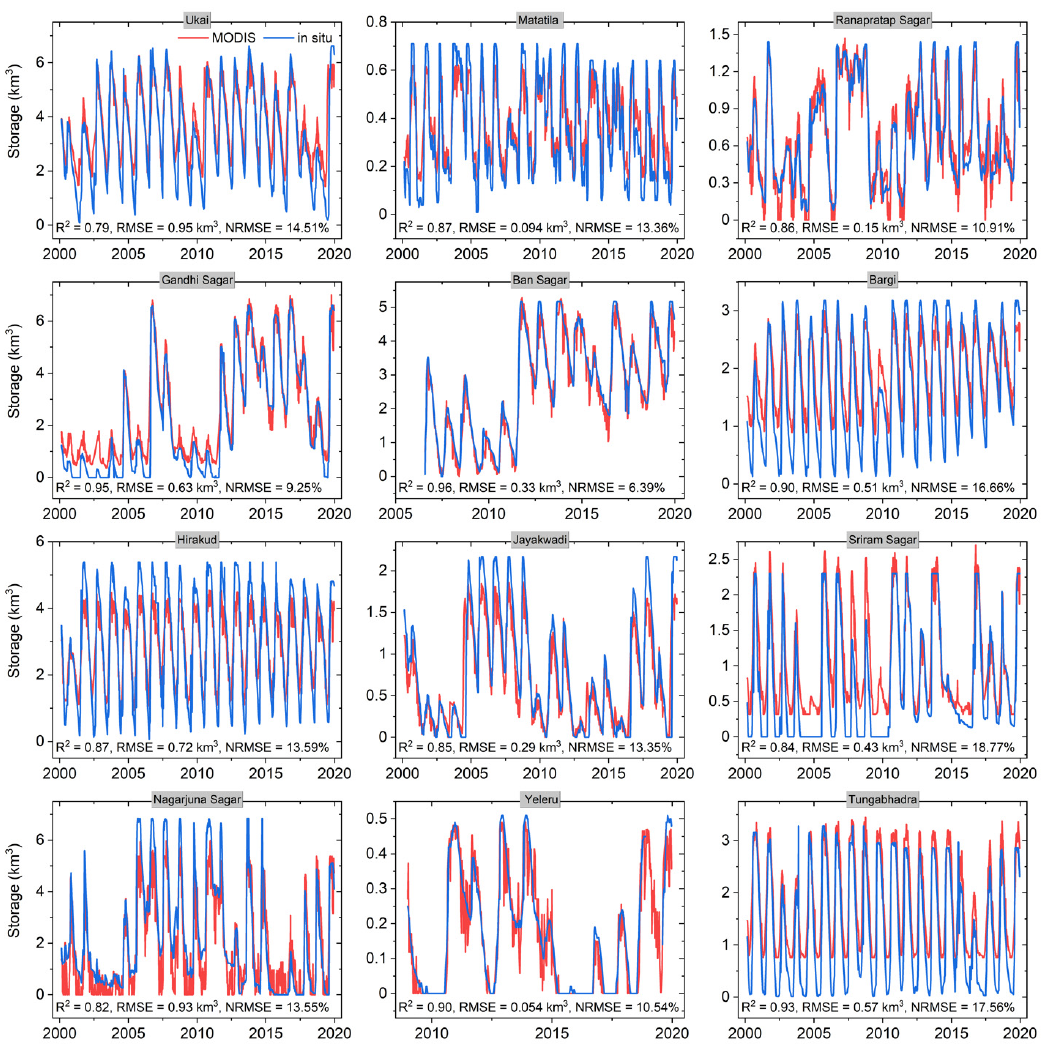
Figure 7. Validation of MODIS 8-day storage products for twelve Indian reservoirs from 2000 to 2019.